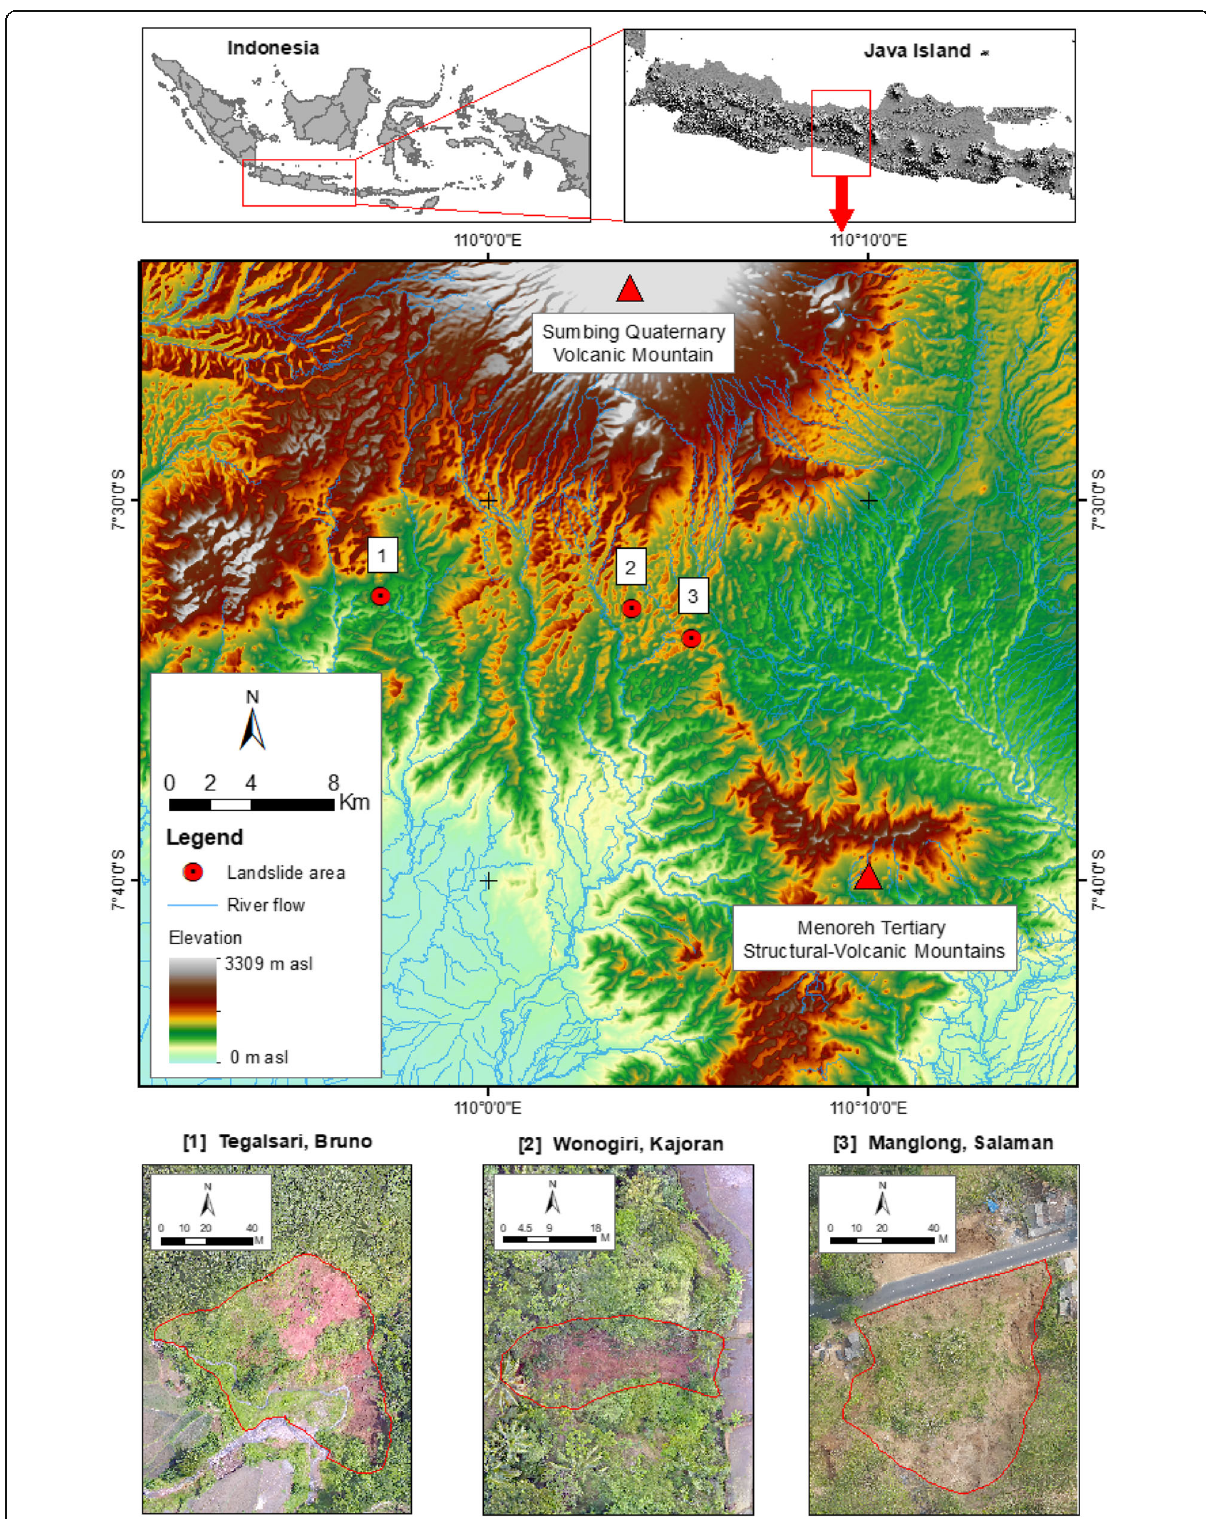
Fig. 1 Location of the landslide study